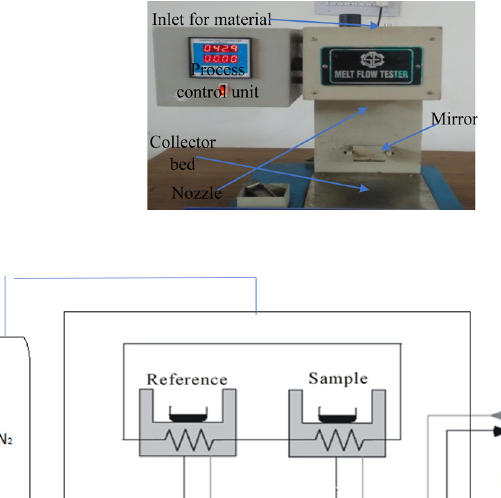
Figure 3. Schematic of DSC